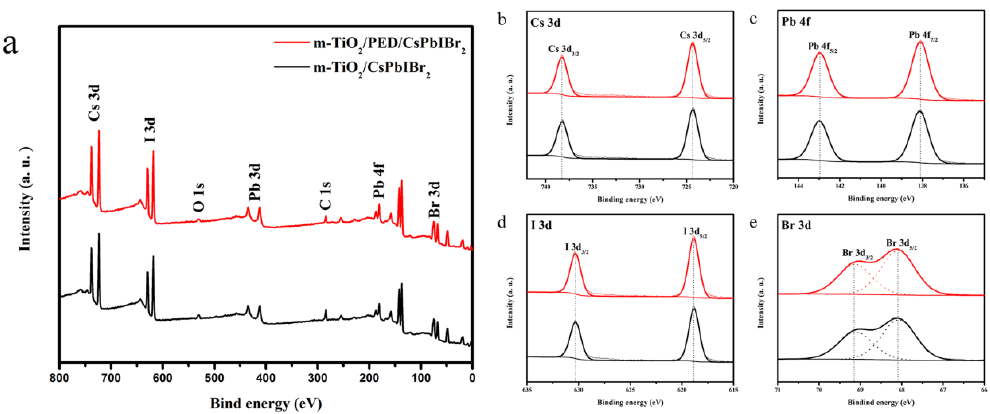
Figure 3. ( a ) XPS spectra and ( b ) Cs 3d, ( c ) Pb 4f, ( d ) I 3d and ( e ) Br 3d XPS core spectra of the m-TiO 2 /CsPbIBr 2 films with and without PED modification.